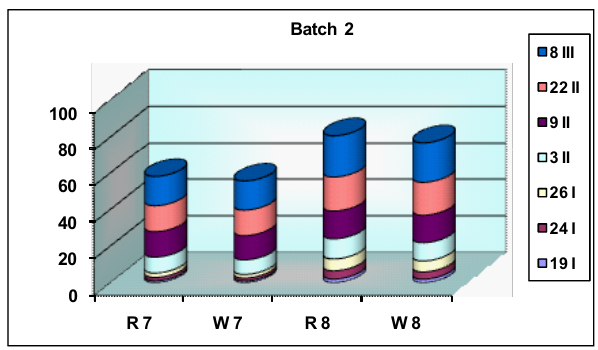
Fig. 6. The final average length of the branches, in cm, for batch